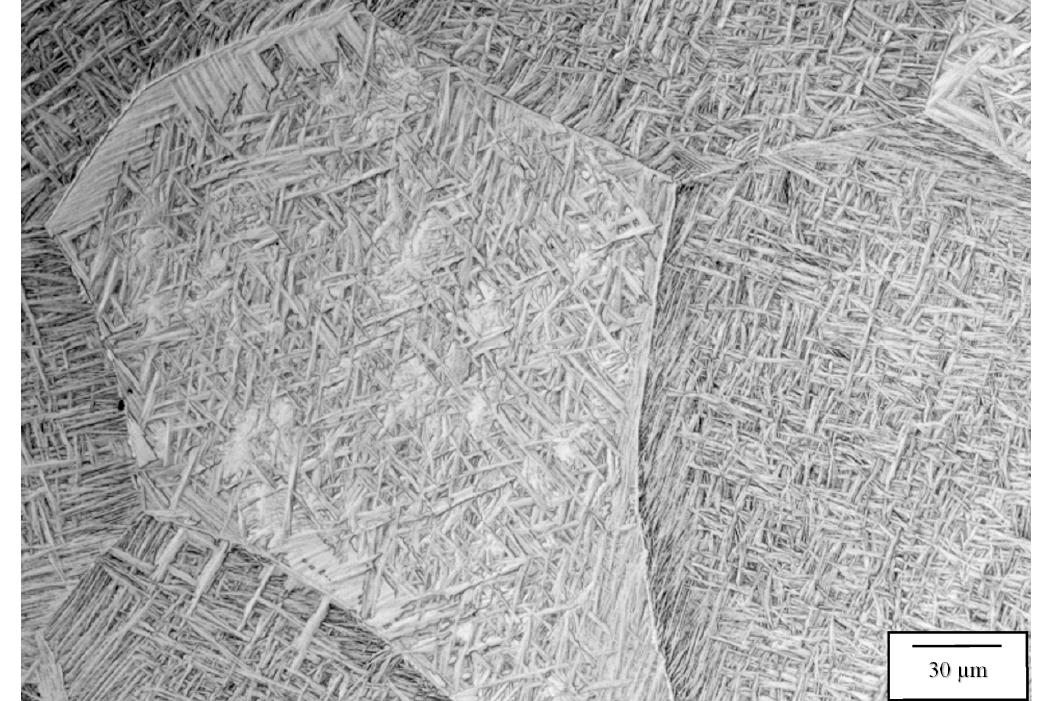
Figure 7. Variant 4 image for the Arcam Q20 top section, X plane.